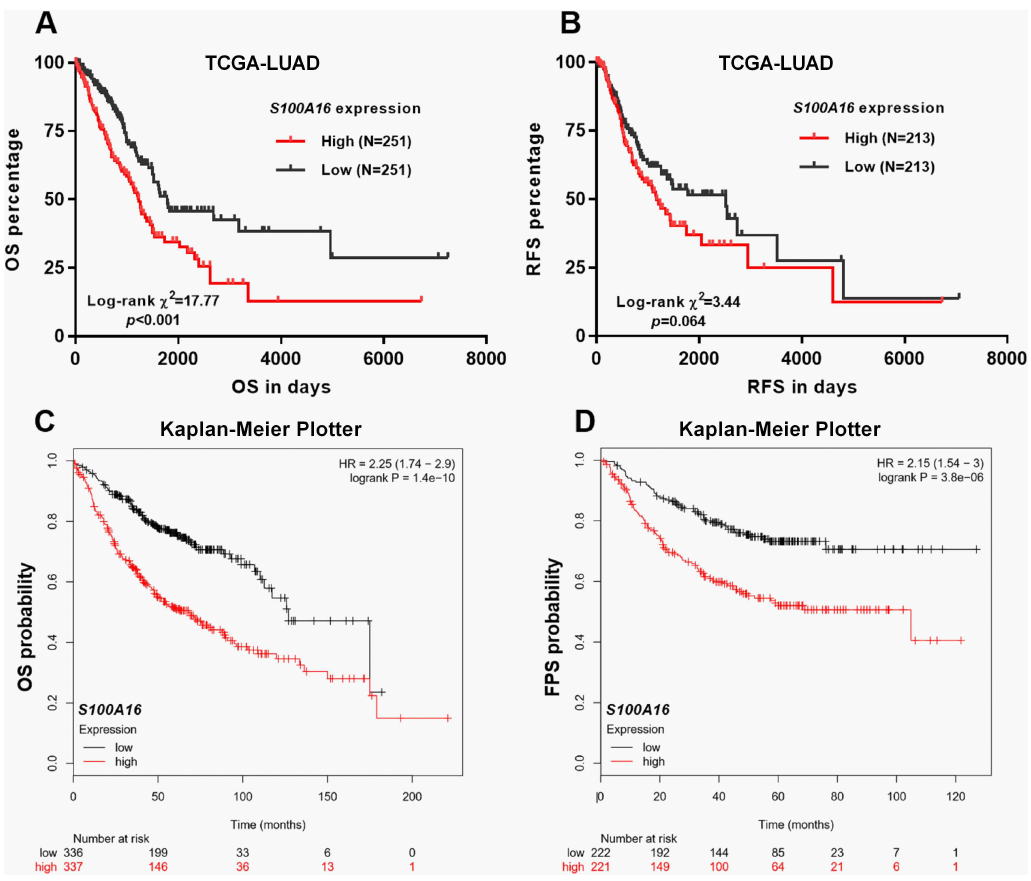
Fig 3. The association between S100A16 expression and OS and RFS in LUAD patients. A-B. Kaplan-Meier curves of OS (A) and RFS (B) in LUAD patients, by using data from TCGA-LUAD. C-D. Kaplan-Meier curves of OS (C) and FPS (D) in LUAD patients. Results were generated by using Kaplan-Meier Plotter. Patients were grouped by the median S100A6